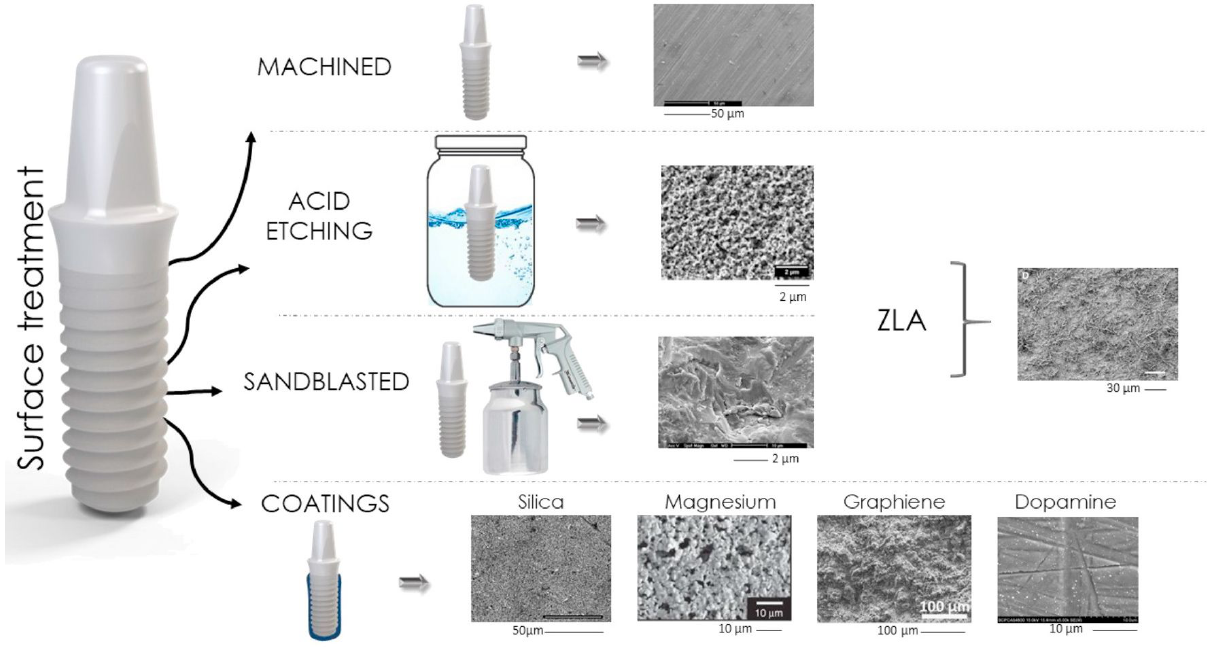
Figure 5: Schematics and SEM images on different zirconia surface modifications: the machined, acid-etched, grit-blasted, ZLA and multi- layered coatings